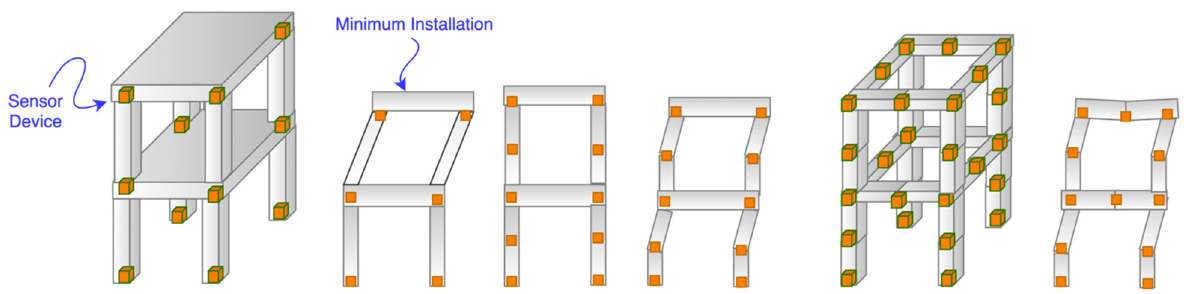
Figure 8. Sensor deployment.